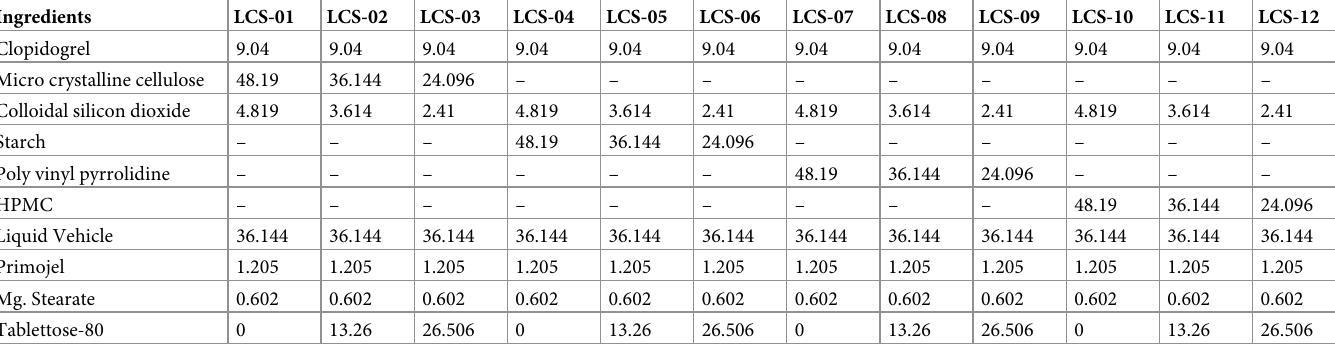
Table 2. Composition of different formulations of liquisolid compacts containing